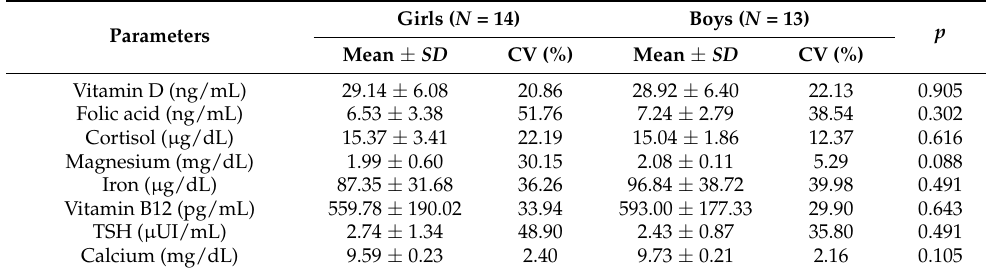
Table 1. Blood composition variables.